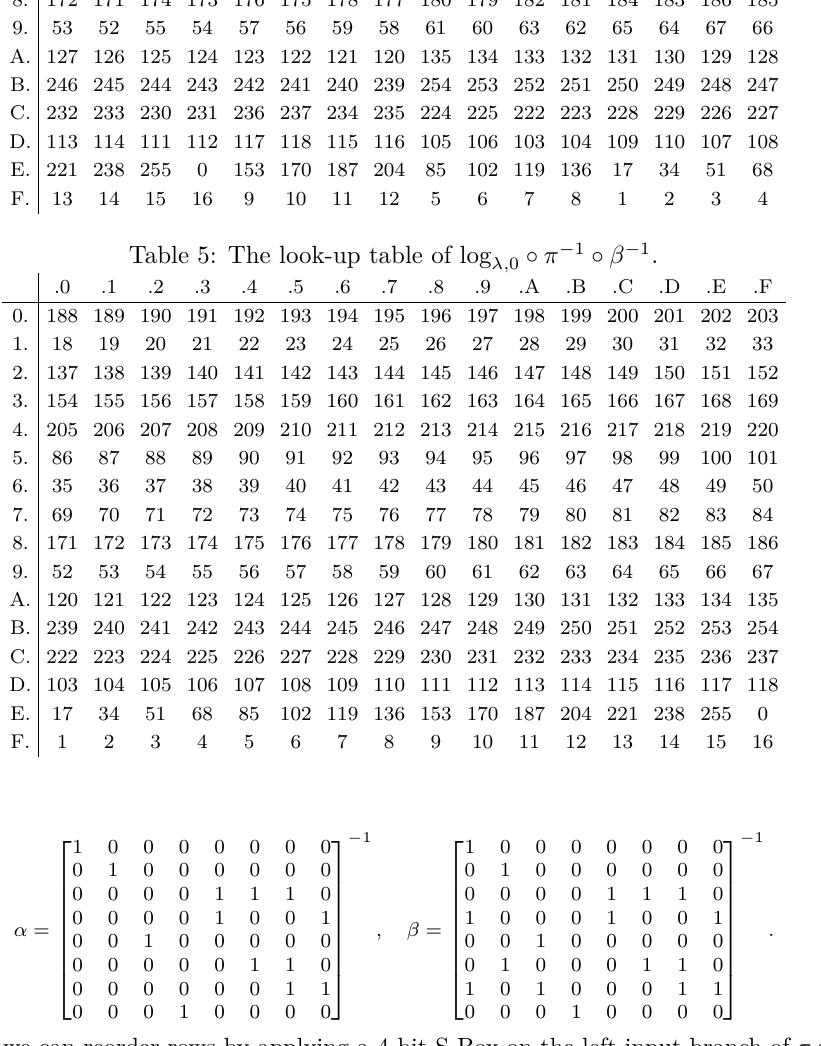
Table 5: The look-up table of log